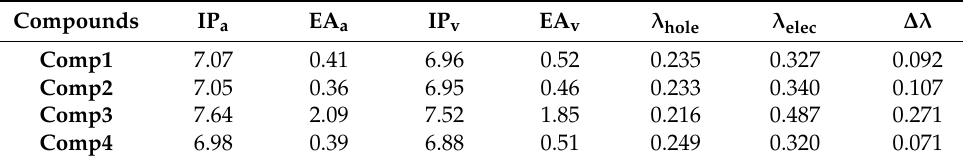
Table 4. Adiabatic/vertical ionization potential (IP a /IP v ), adiabatic/vertical electron affinity (EA a /EA v ), and electron/hole reorganization energies ( λ elec / λ hole ) in eV of benzothiazoles at the B3LYP/6-31+G**